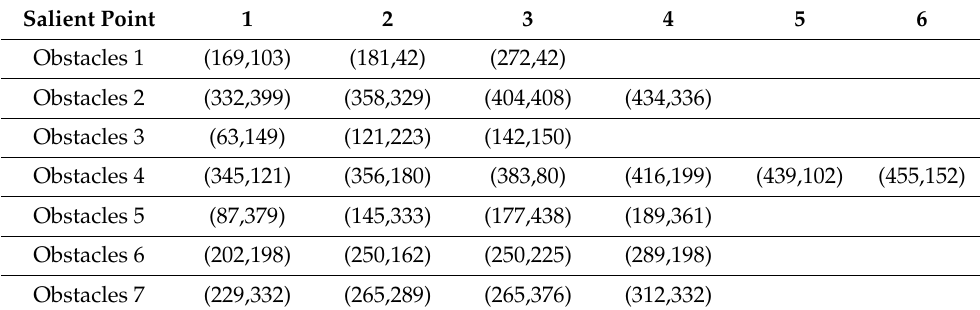
Table 4. Coordinates of salient points under plane with moderate obstacles condition.